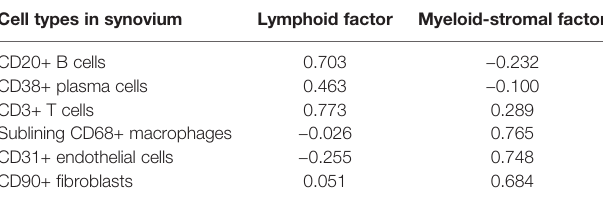
TABLE 2 | Matrix of rotating factor loadings for two synovial cellular patterns.